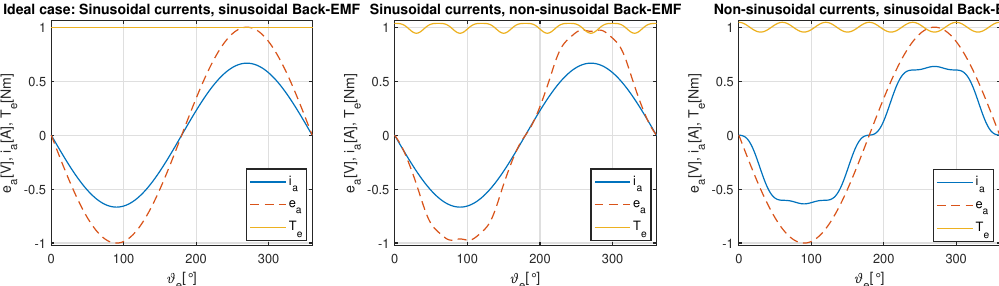
Figure 2. Ripple in produced T e based on misalignment between stator currents and Back-EMF voltages. Mechanical torque on the shaft is expressed